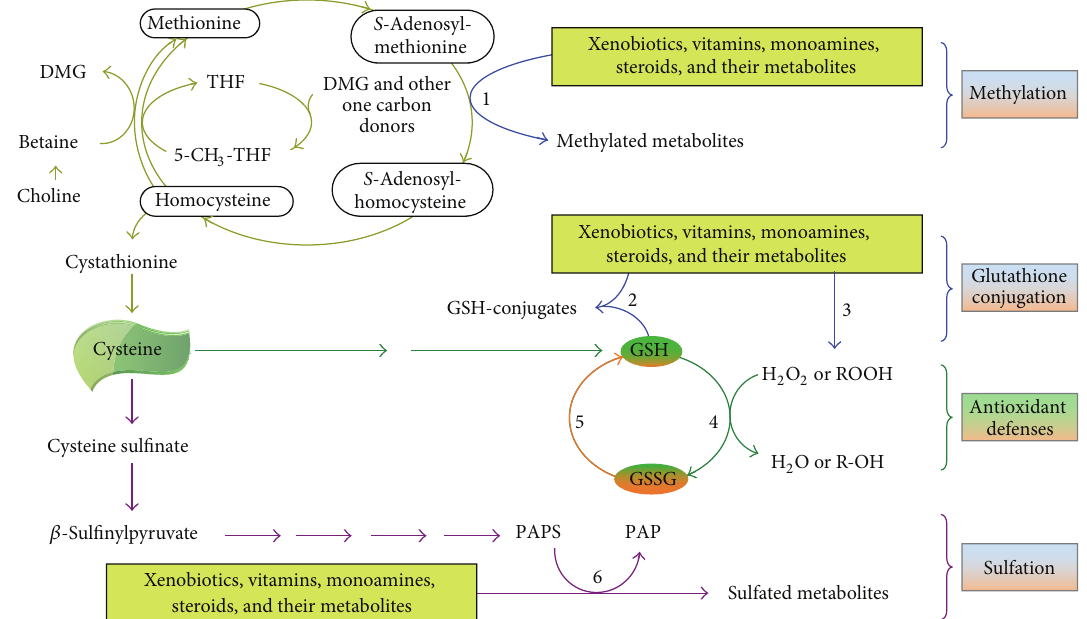
Figure 2: Role of methyl groups and sulfur amino acids in the detoxification system. Methylation, sulfation, glutathione conjugation, and glutathione-mediated antioxidant defense are major components of the detoxification system. An adequate supply of methyl donors, primarily betaine and choline, is a prerequisite for methylation reactions. Glutathione, formed from cysteine, is required for glutathione conjugation and the clearance of hydrogen peroxide and hydroxyl radicals, while 3 󸀠 -phosphoadenosine 5 󸀠 -phosphosulfate (PAPS), derived from the metabolism of sulfur amino acids, is the universal sulfate donor for all sulfation processes. Excess vitamins may disturb the degradation of monoamine neurotransmitters by depleting the body’s methyl-group and sulfate pools. 1, methyltransferases; 2, glutathione S -transferase; 3, phase I xenobiotic-metabolizing enzymes; 4, glutathione peroxidases; 5, glutathione reductase; 6, sulfotransferases. 5-CH 3 - THF: 5-methyltetrahydrofolate; DMG: dimethylglycine; GSH: reduced glutathione; GSSG: oxidized glutathione; PAP: 3 󸀠